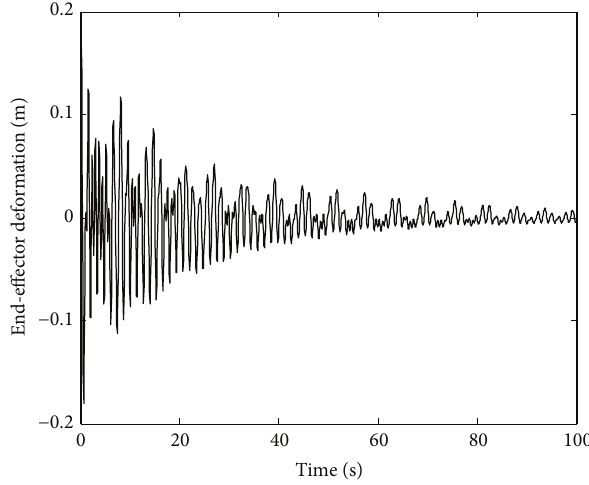
Figure 13: Response of the controlled arm ( 𝛿(𝑙, 0 ) = 0 . 2